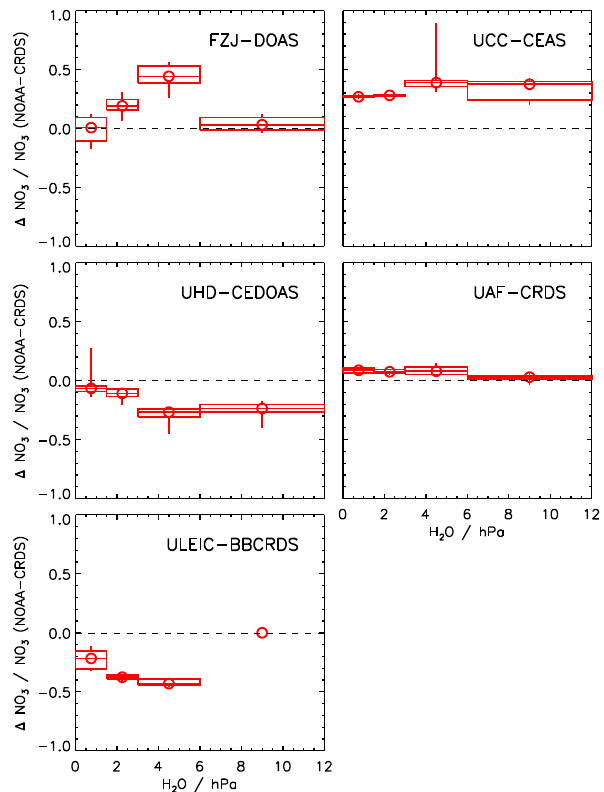
Fig. 10. Box-and-whisker plot of the relative difference of NO 3 measurements between various instruments and the reference NOAA-CRDS as function of the H 2 O partial pressure during the chamber experiment on 10 June. Dots are medians, boxes give the first and third quartile and whiskers denote the 10th and 90th per-